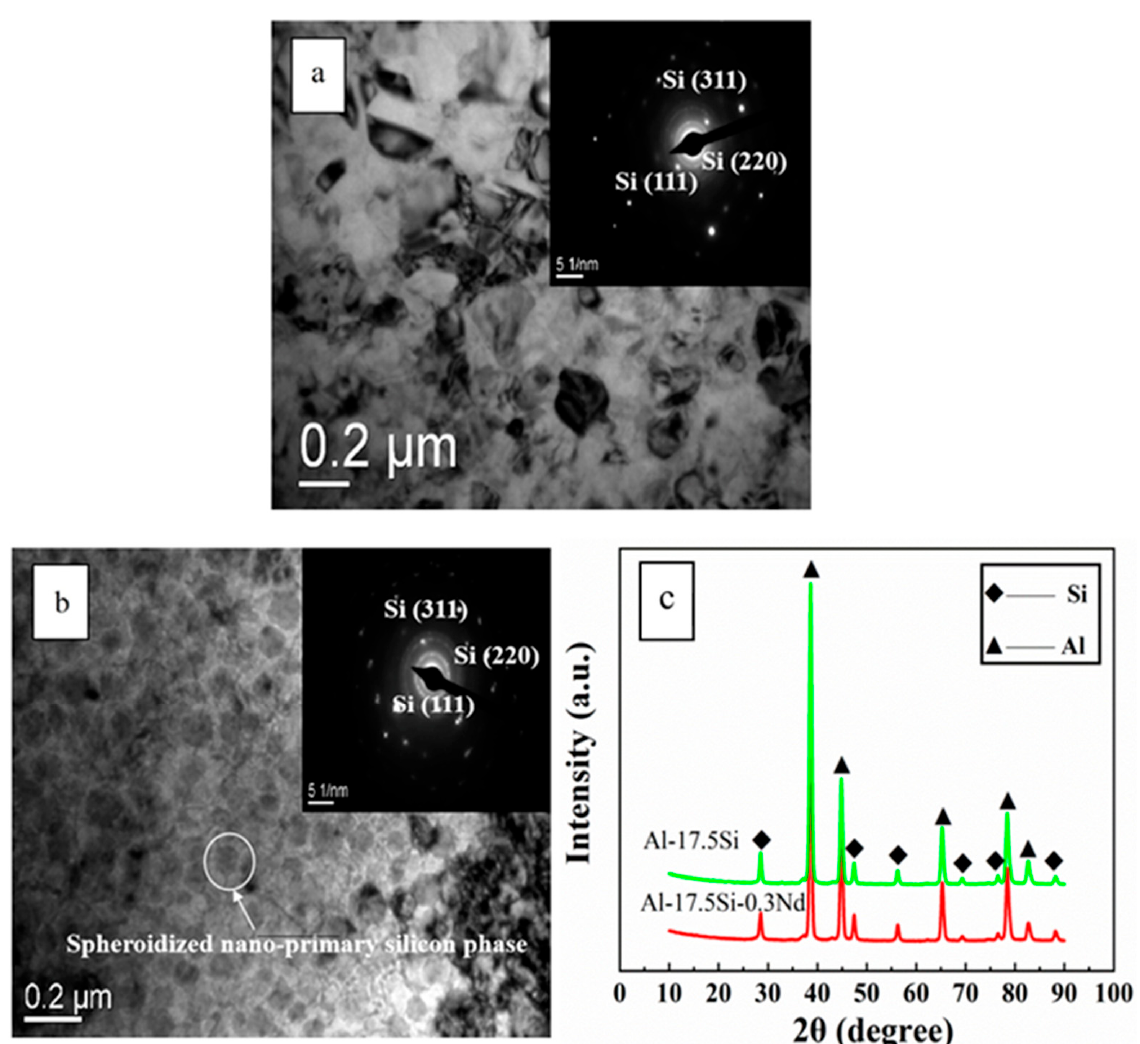
Figure 1 Figure 1. Nano-primary silicon phase formed in the surface layer of a 25-pulsed Al–17.5Si alloy without Nd and with Nd. ( a ) Unmodified nano-primary phase; ( b ) Spheroidized nano-primary silicon phase; ( c ) XRD plot corresponding to Figure